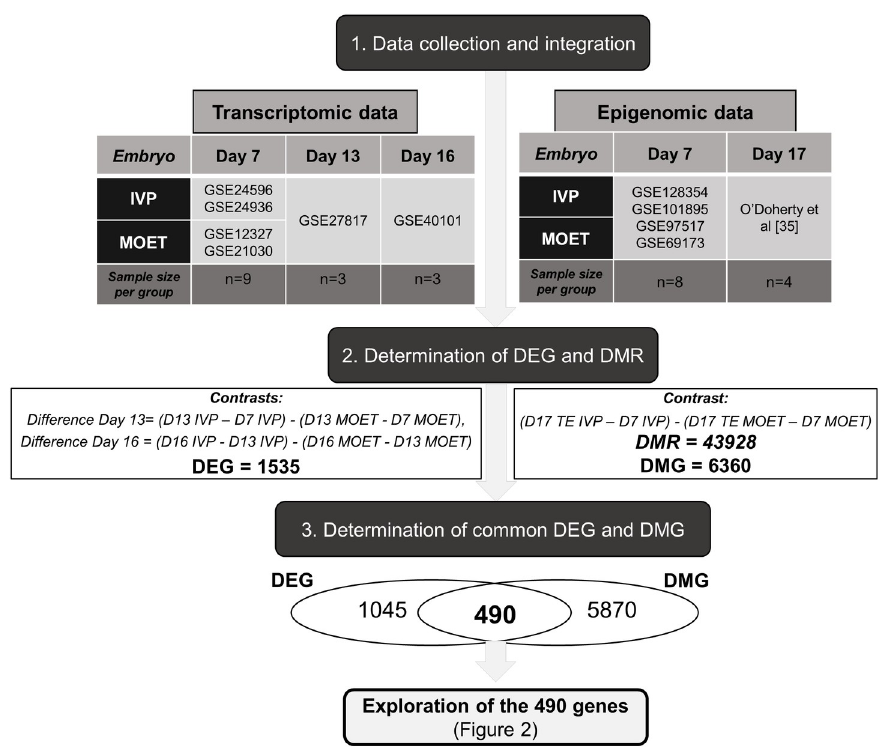
Fig 1. Pipeline of the methodology followed in this study. Step 1: Datasets with the accession number GSE# were downloaded from the Gene Expression Omnibus (GEO) or were obtained from a previous study [35] and processed for data integration. Step 2. Temporally differentially expressed genes (DEG) from day 7 (D7) to D13 and D16 and differentially methylated regions (DMR) in the trophectoderm (TE) from D7 to D17 were determined between groups. Differentially methylated genes (DMG) were the genes in the corresponding exons of the DMR. Step 3. DEG and DMG were overlapped to determine common genes, which were further analysed (Fig 2). Each step is explained in detail in the methodology section. IVP: embryos produced in vitro . MOET: embryos produced in vivo (after ovarian superovulation).